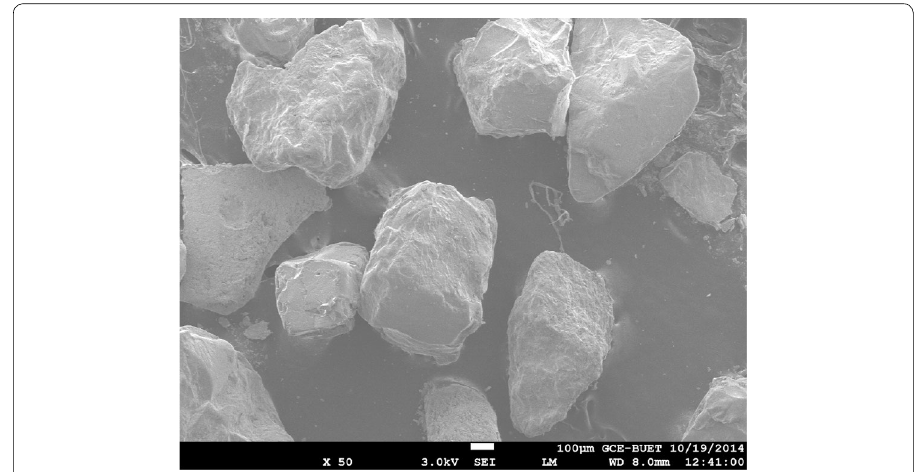
Fig. 2 Scanning electron microscopic view of sand